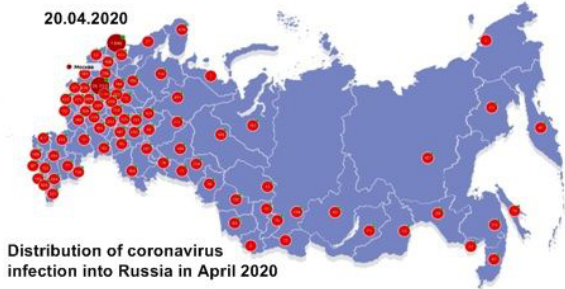
Figure 13. Distribution of coronavirus infection into Russia in